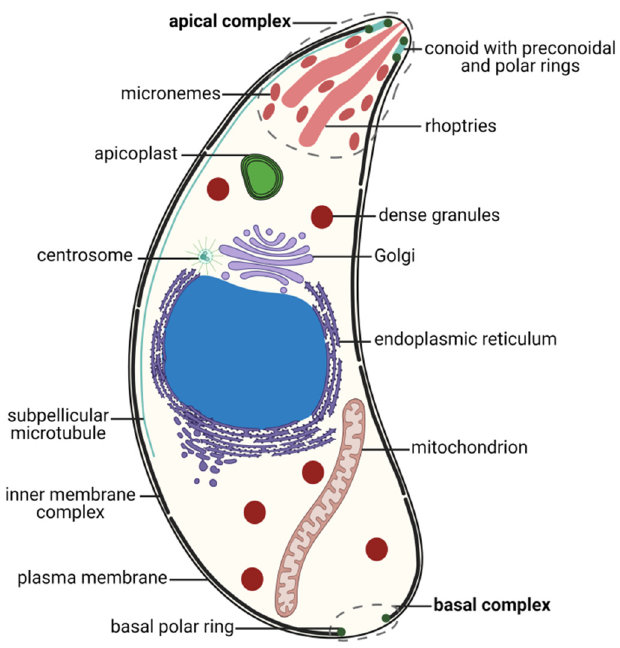
Figure 1. Morphology of the Toxoplasma gondii tachyzoite. Schematic drawing of a transverse cut of a T. gondii tachyzoite with the main organelles and structures represented. The apical and basal complexes are highlighted with grey interrupted lines. Created with BioRender.com (accessed on 5th December 2021).